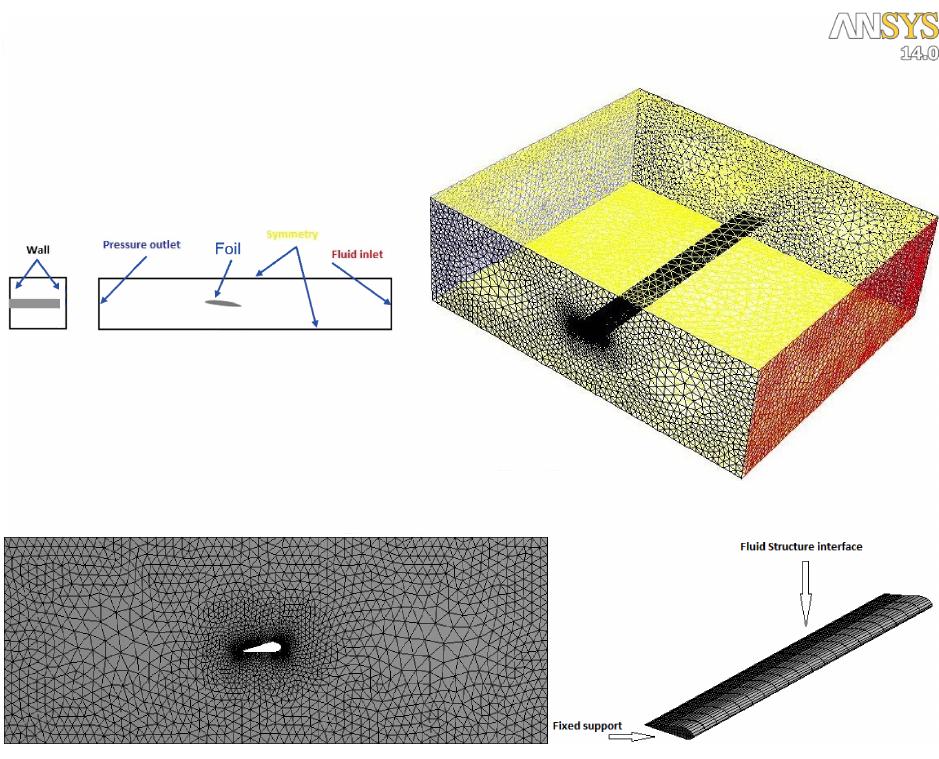
Figure 5. Computational mesh and boundary conditions. Table 1 representes the material and geometrical properties of the coupled system: Table 1. Material and geometrical properties.